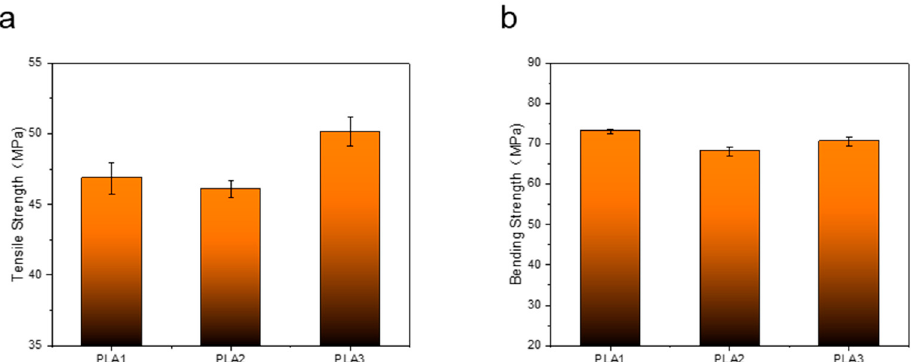
Figure 10. ( a ) Tensile strength of samples under different ultrasonic strengthening methods. ( b ) Bending strength of samples under different ultrasonic strengthening methods.